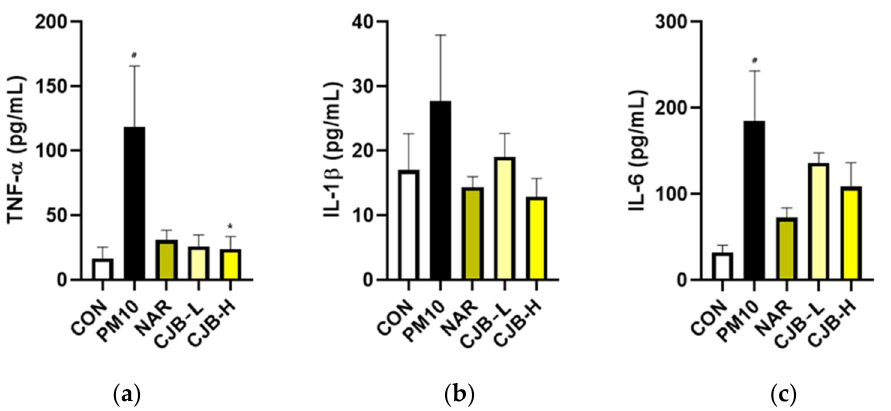
Figure 3. The expression of pro-inflammatory cytokines in the BALF from PM10-treated mice. ( a ) TNF- α , ( b ) IL-1 β , and ( c ) IL-6 protein expression. All values are expressed as the mean ± SEM. A p -value under 0.05 was considered statistically significant. # indicates statistical significance compared to the CON group, and * indicates statistical significance compared to the PM10 group. CON, normal control; PM10, negative control; NAR, naringin at 100 mg/kg; CJB-L, CJB at 100 mg/kg; CJB-H, CJB at 200 mg/kg.